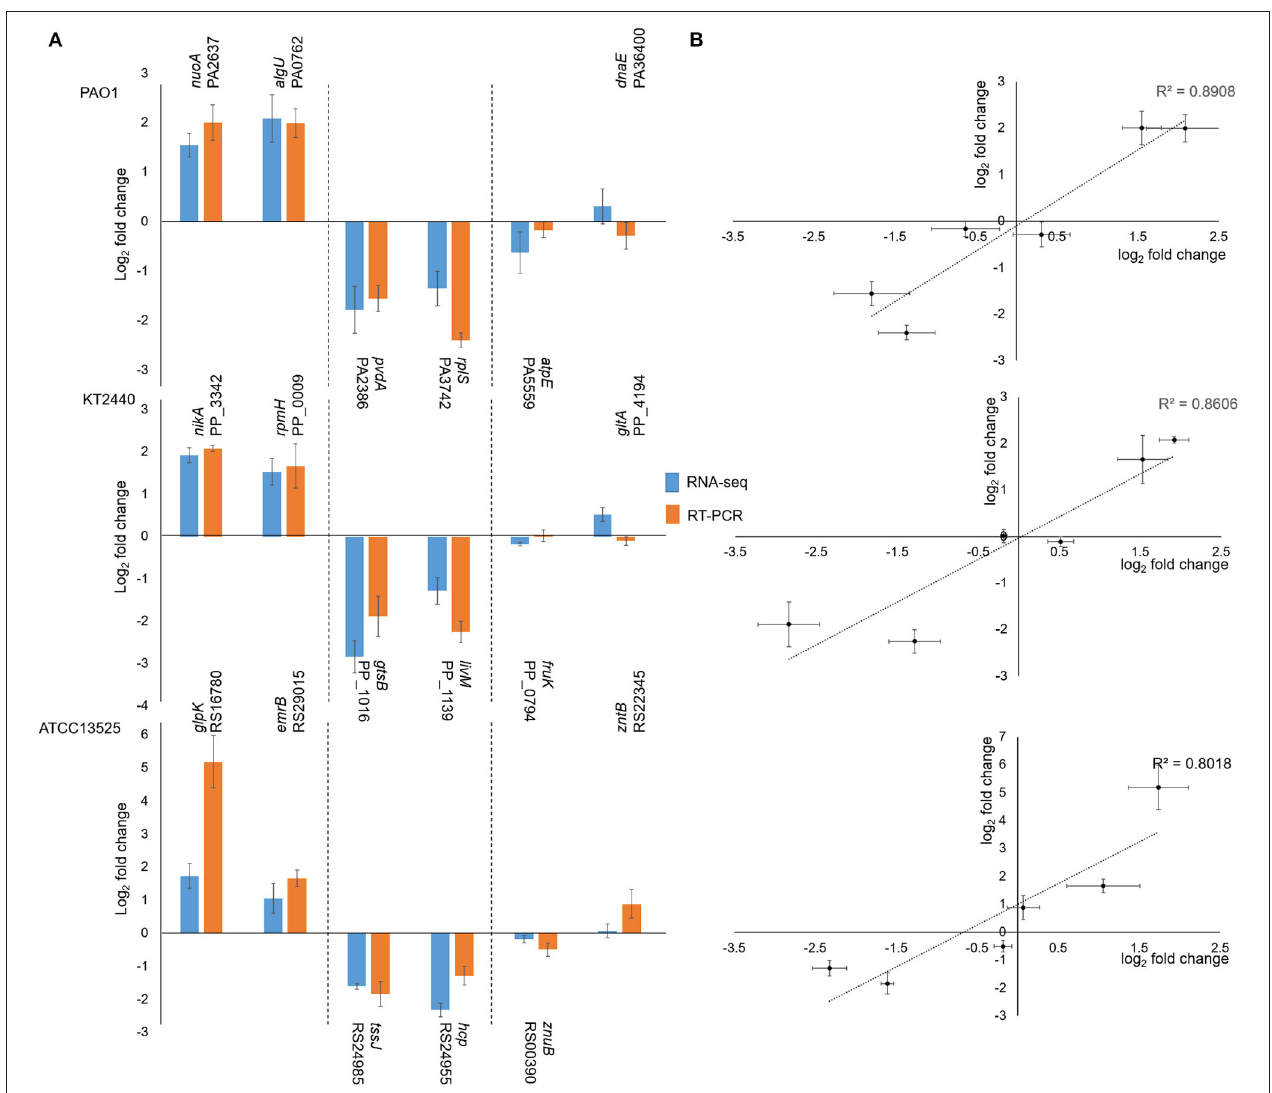
FIGURE 2 | Correlation between the results obtained by RNA-seq and RT-PCR. (A) Rectangles represent fold changes of selected genes. Bars illustrate standard deviations of three replicates. (B) Correlation plot between fold change values of selected genes observed by RNA-seq and RT-PCR. Horizontal bars represent standard deviations for RNA-seq data, and vertical bars illustrated standard deviations of RT-PCR results. As the fold change values followed the normal distribution, Pearson’ coefficients were calculated.